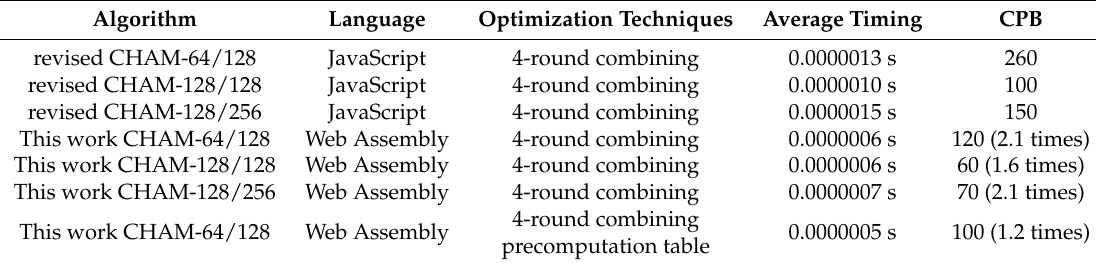
Table 11. Revised CHAM algorithm performance in Firfox (CPB : Cycle Per Byte).